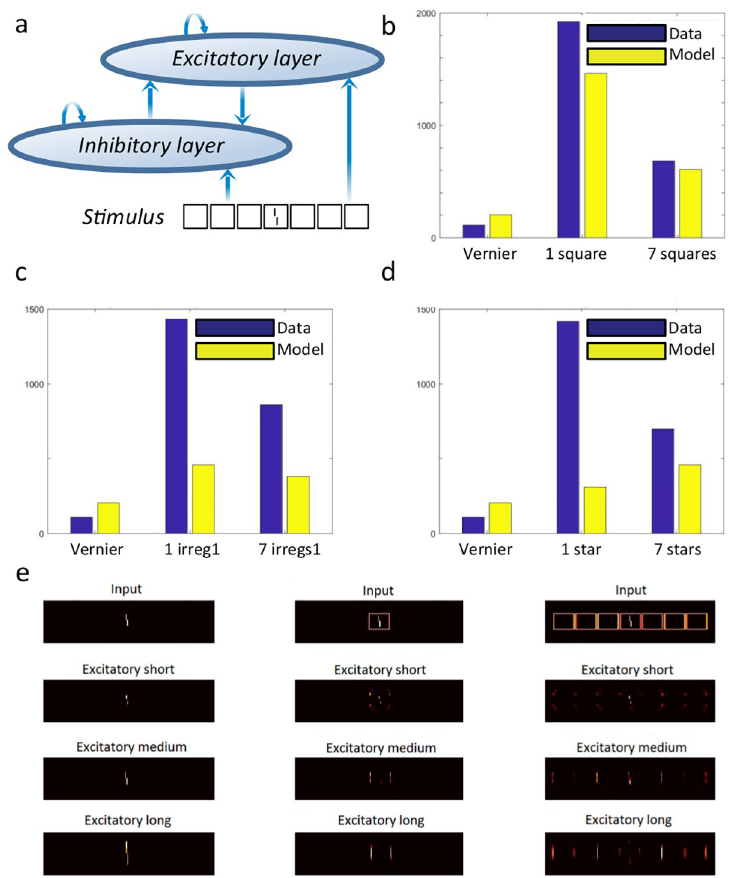
Fig 8. Wilson and Cowan network with end-stopped receptive fields: a. Structure of the network in [39] which we augmented with end-stopped receptive fields. An excitatory and an inhibitory layer of neurons are activated by the stimulus and interact with one another. The output of the excitatory layer is cross-correlated with a vernier template to measure performance. b. Output for the squares category (with psychometric function fitted on the squares category). In accordance with human results, performance is better in the 7 squares than in the 1 square case. c. Output for the irregular category (with psychometric function fitted on the squares category). Performance is marginally better in the 7 irregular1 than in the 1 irregular1 case. d. Output for the stars category (with psychometric function fitted on the squares category). There is no uncrowding for this stimulus. Uncrowding occurs only for specific kinds of stimuli, where element size regularities seem important. Further, performance depends strongly on which data are used for the training set (i.e., for fitting the psychometric function), suggestive of overfitting. e. Model output images. Columns are different stimuli: vernier, 1 square and 7 squares. The first row shows the stimuli, and the three subsequent rows show the model output for the short, medium and long end-stopped receptive fields. The crucial result is that the vernier is better represented in the short and medium populations in the 7 squares than in the 1 square conditions (i.e., uncrowding occurs). As mentioned, uncrowding occurred for very few stimuli categories. In cases that didn’t show uncrowding, the vernier representation deteriorated further when flankers were added (see results on the online repository). Note: the model outputs a cross-correlation quantifying how similar the model output is to the model output in the vernier alone condition (so the higher this cross-correlation, the better the performance). To make comparisons with human thresholds easier, we applied the same linking hypothesis as Hermens et al. [39]: we fitted a psychometric function to link model outputs to behavioural results, as explained in the main